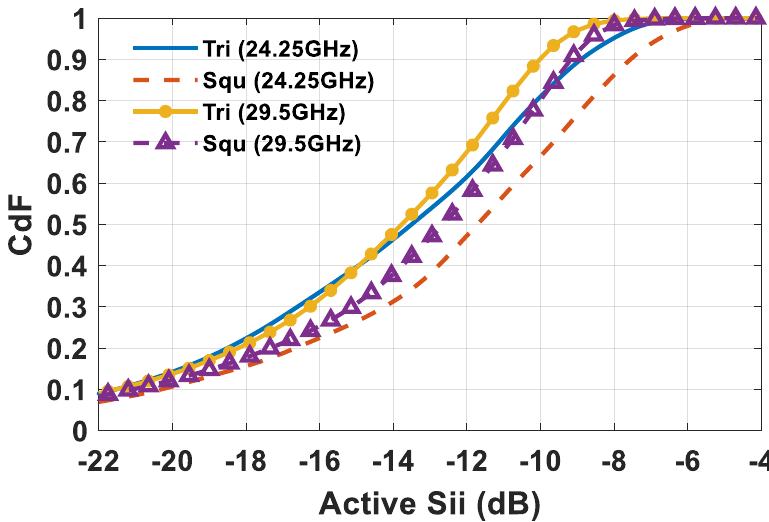
Figure 12. Active S ii CDF for square and equilateral triangular lattice planar arrays composed of 64 elements at 24.25 and 29.5 GHz.